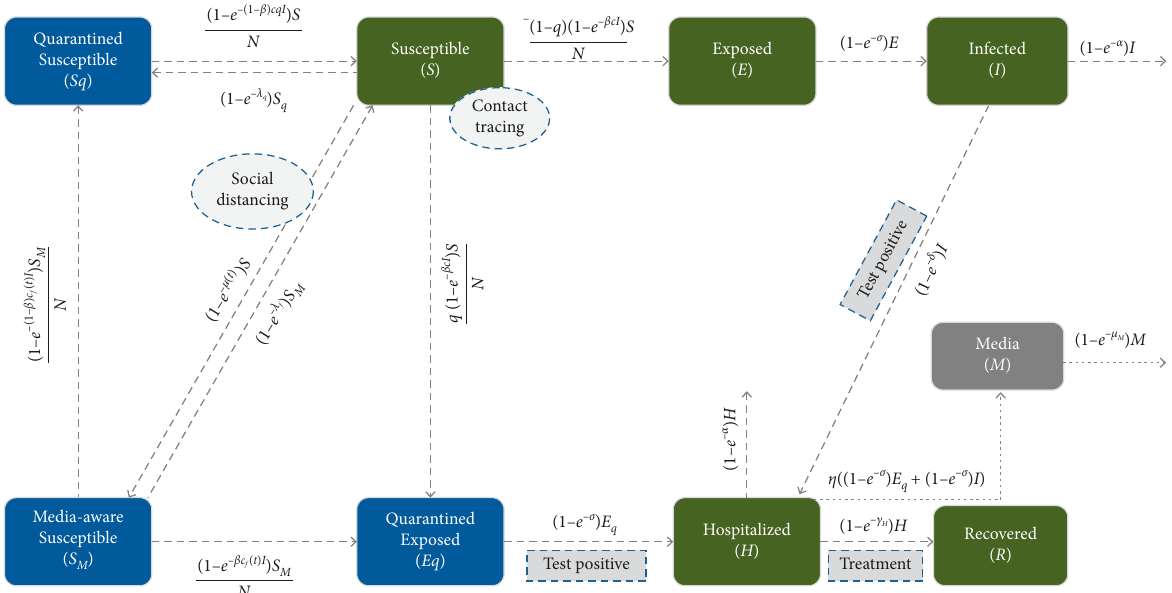
Figure 4: Flow diagram of the model for illustrating the COVID-19 infection dynamics in Beijing city. Intervention measures—including contact tracing, quarantine, and isolation—are illustrated. The media-aware susceptibles have lower probability of transmission and will eventually relax from social distancing and move back into susceptible